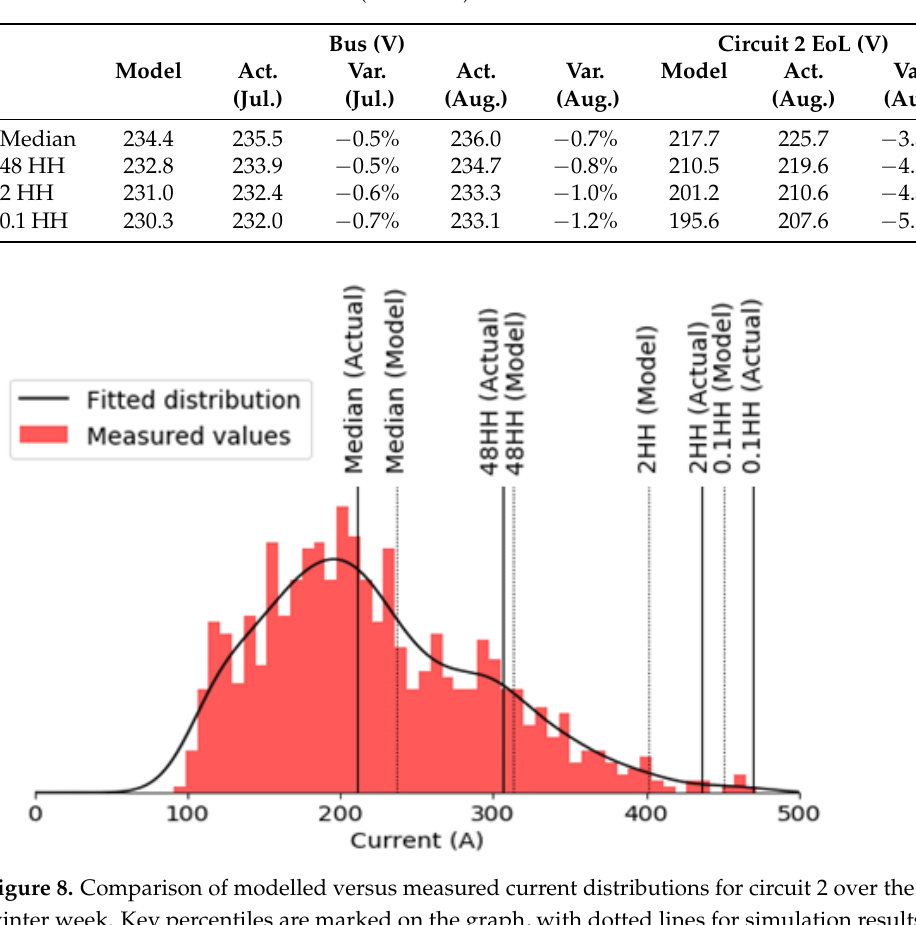
Table 10. Comparison of modelled versus actual (measured) voltage percentiles for the LV trans- former bus and at the EoL of circuit 2 (branch 36).